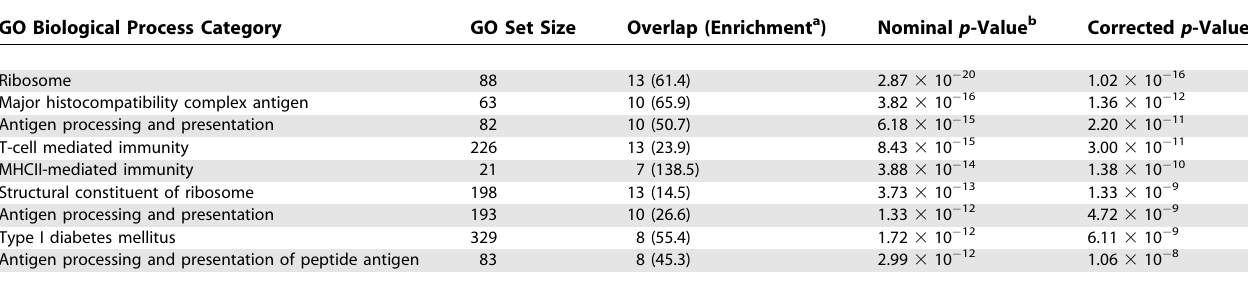
Table 3. GO Biological Process Categories Enriched in the RPS26 Subnetwork Depicted in Figure 1A GO Biological Process Category